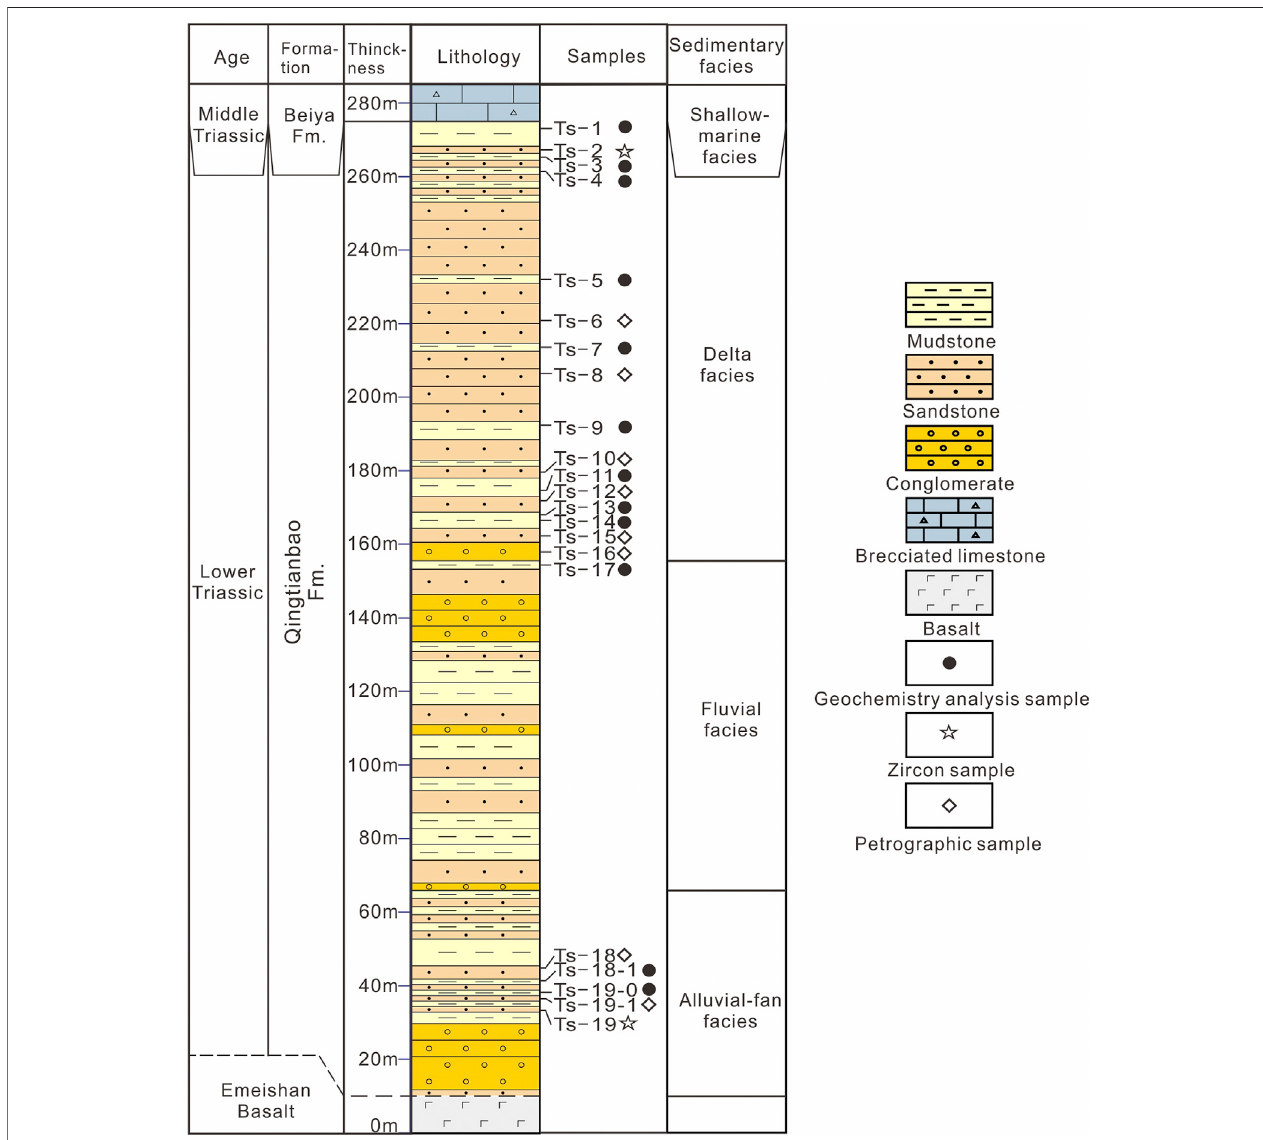
FIGURE 3 | Simpli fi ed stratigraphic section and sampling locations at Dengchuan (modi fi ed after Zhou et al., 2013).